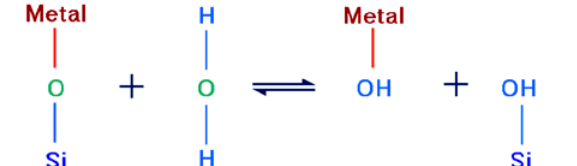
Figure. 41. Accumulated sediments contain re-mobilised sediment lenses and diapirs.